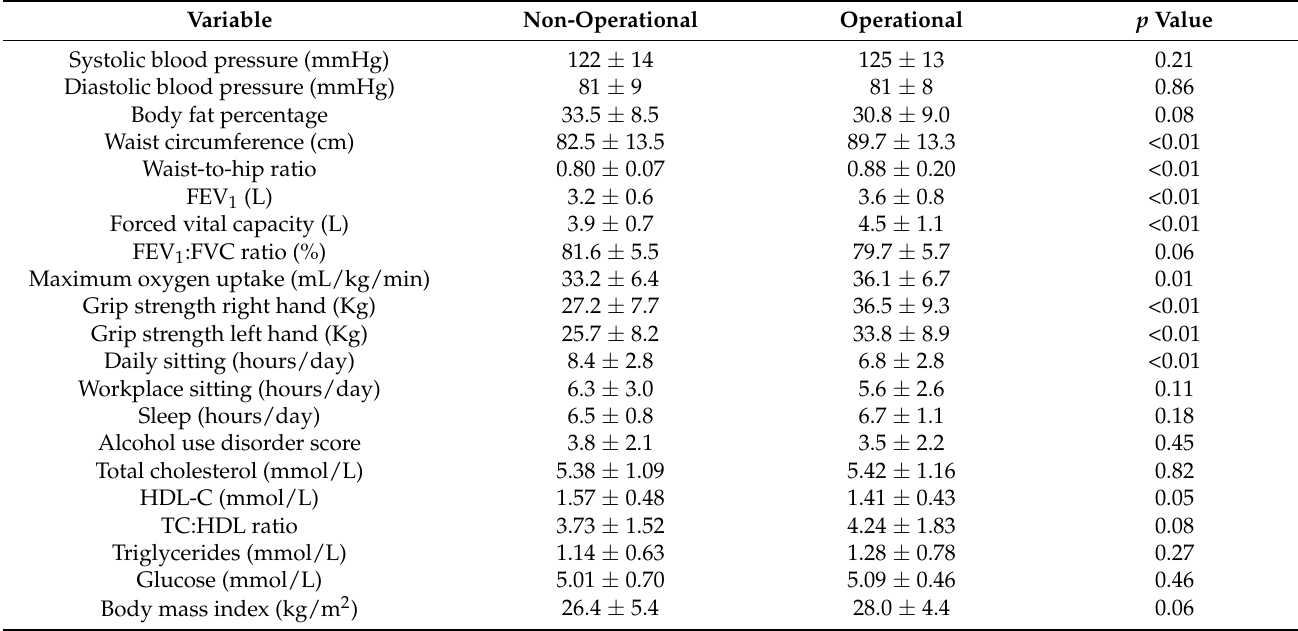
Table 4. Differences in measures of health, health behaviours, and fitness between operational and non-operational police workers ( n = 137). Data presented as mean ±